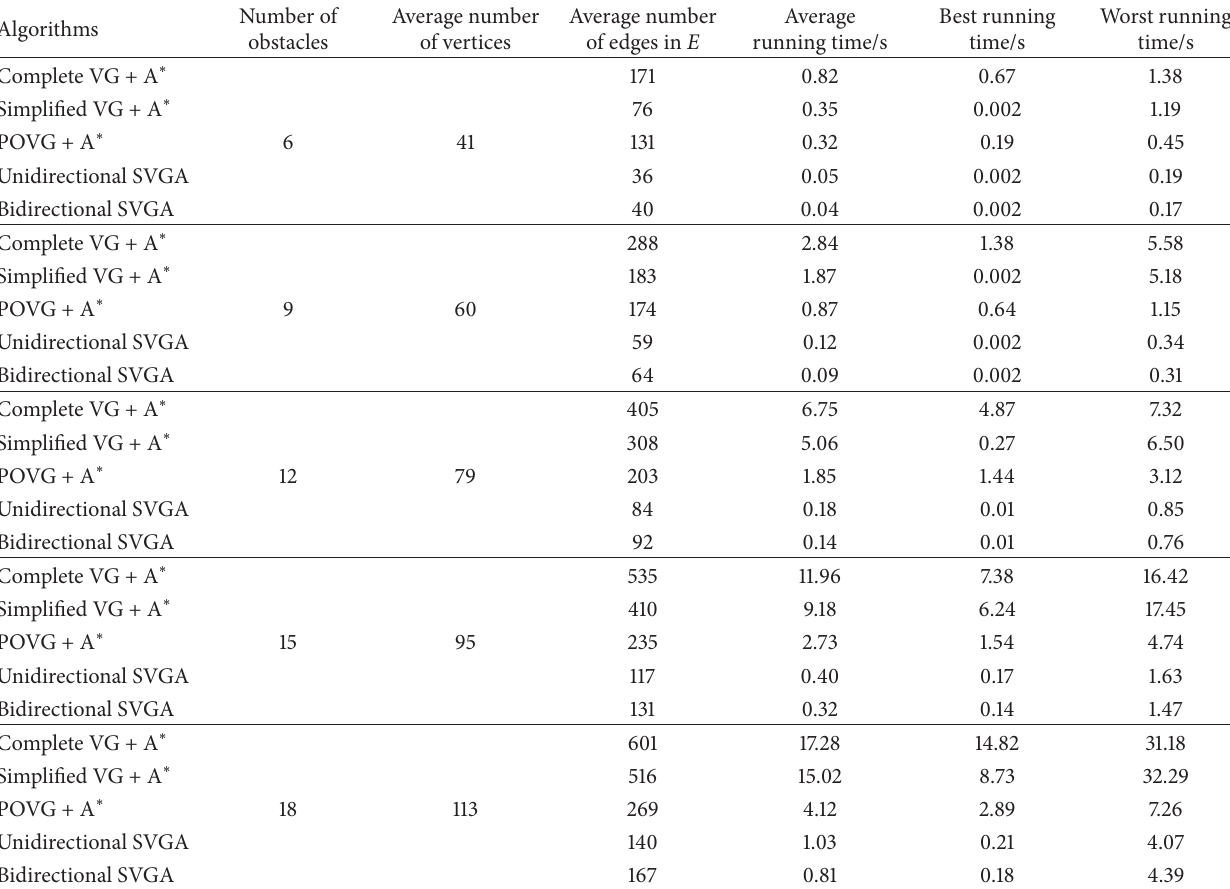
Table 1: Experimental results in 2D environment with randomly generated